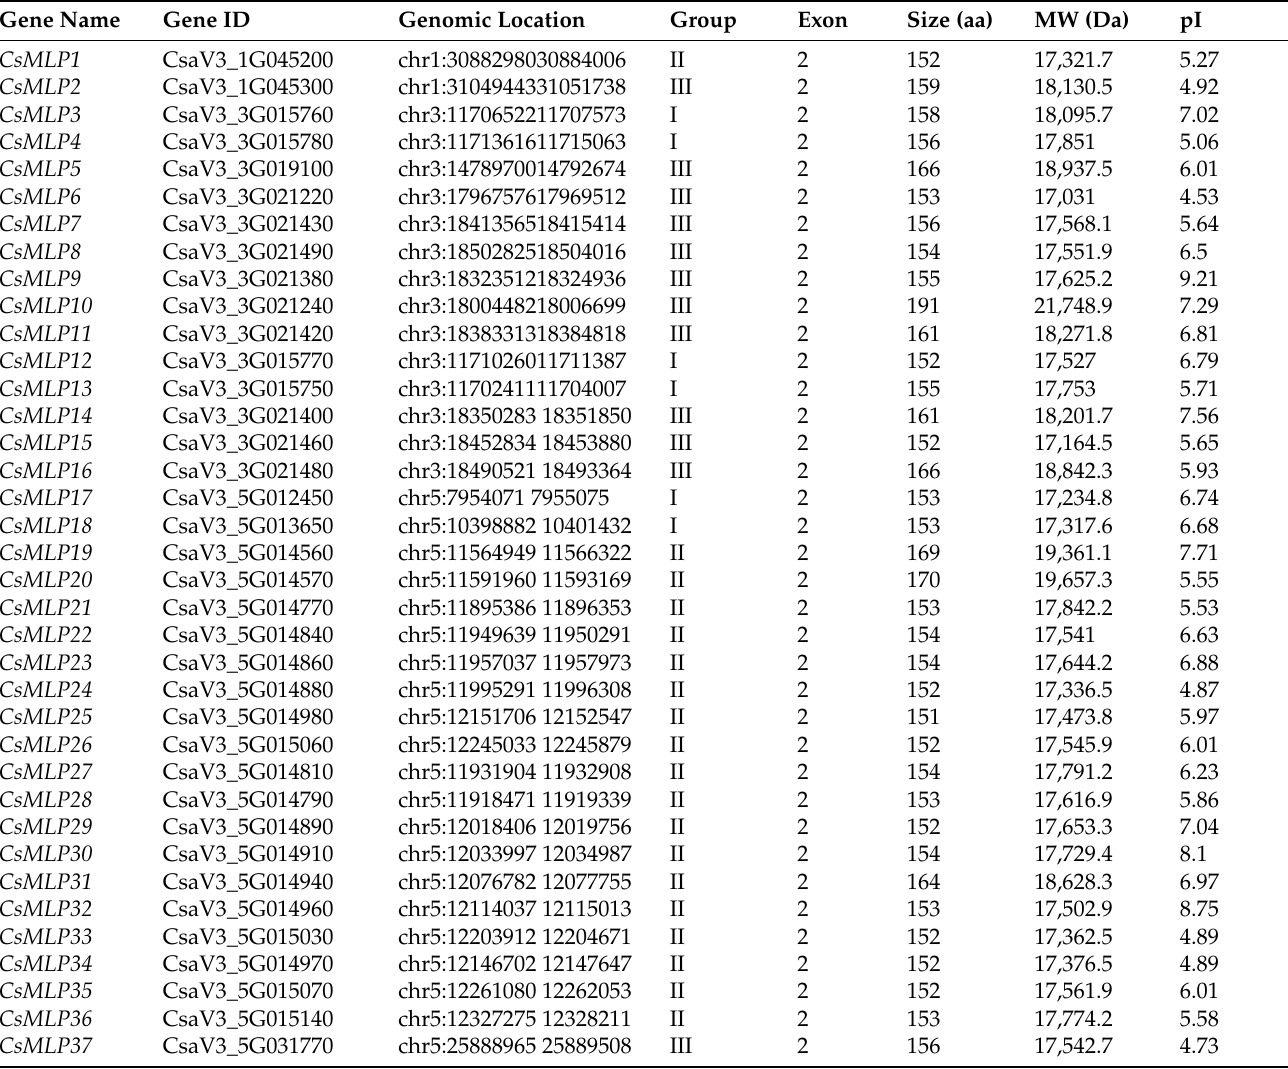
Table 1. Characteristics of MLP family members in